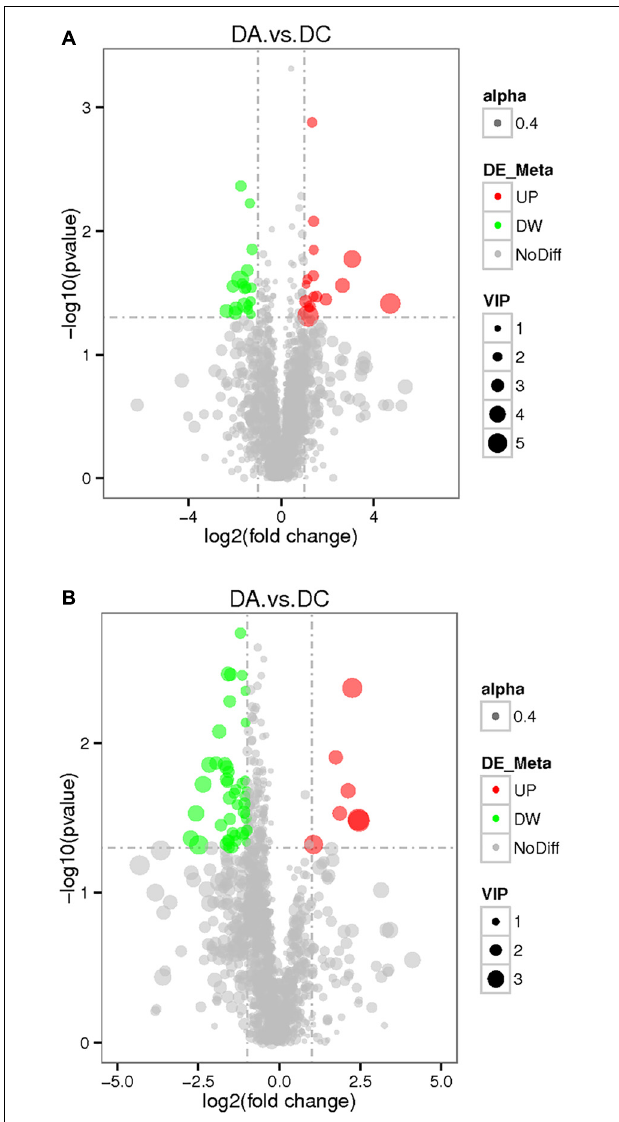
FIGURE 8 | The volcano map of differential metabolites in estrus Diannan small ear sows. (A) Positive ion mode and (B) negative ion mode.